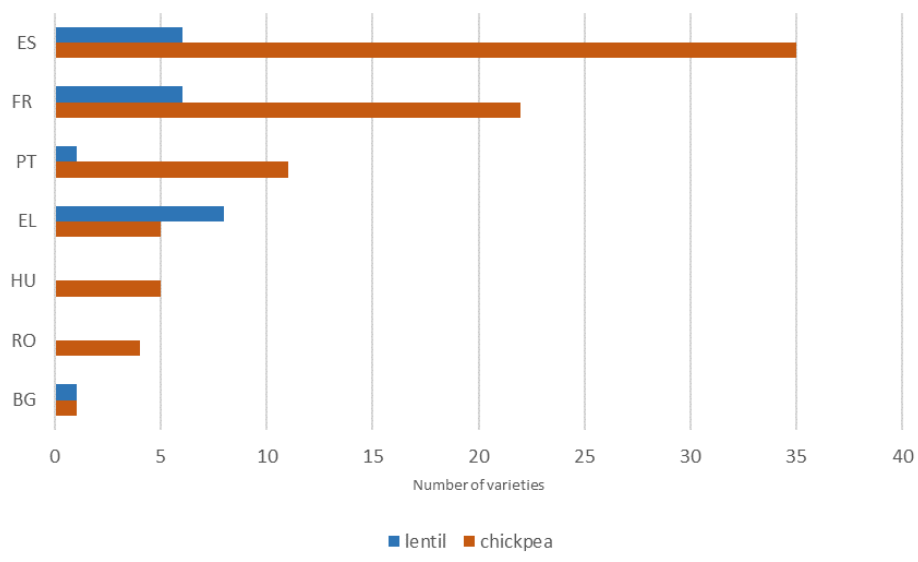
Figure 19. Number of chickpea varieties in EU countries [47–64].